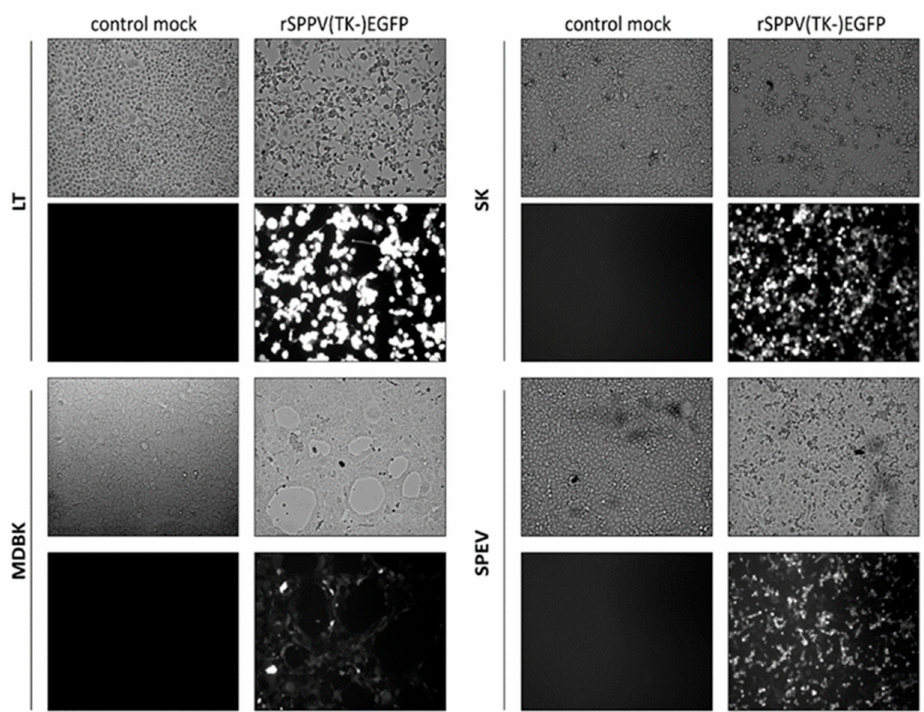
Figure 6. Assessment of EGFP gene expression by fluorescent microscopy (10 × ). Cytopathic effect of the virus and expression analysis of EGFP in cells of permissive (LT) and non-permissive (SK, MDBK and SPEV)